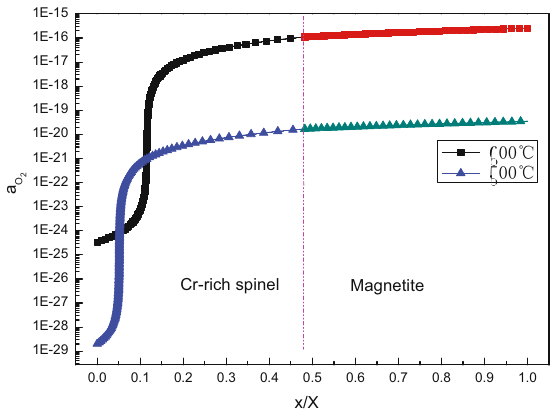
Figure 6: Relationship between iron diffusion coefficient and nor - malized position ( x / X ) in oxide scale on